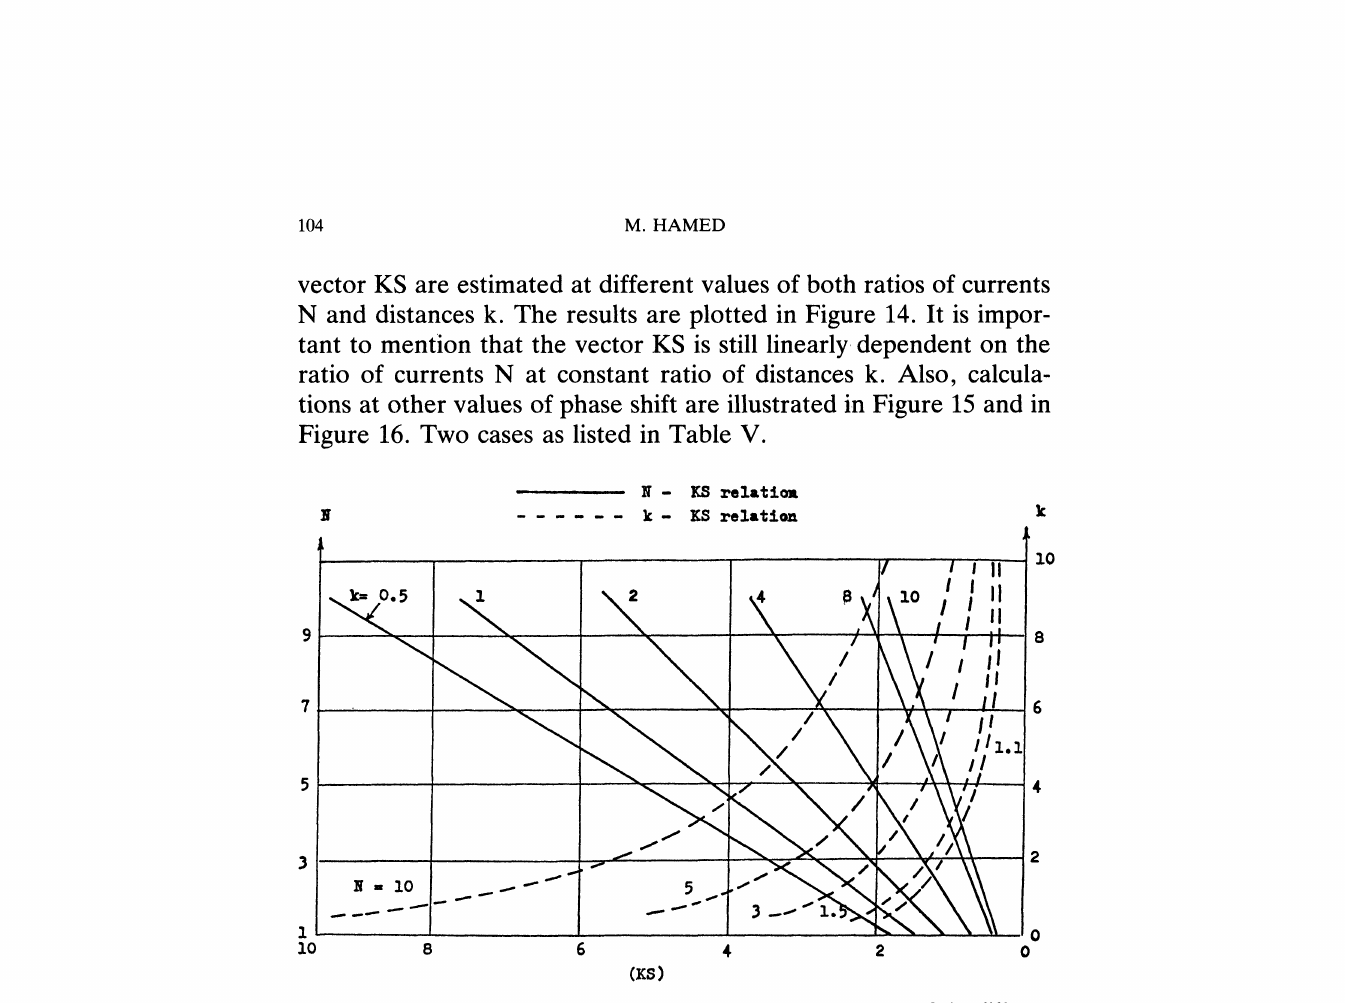
FIGURE 14 The calculated values of the coefficient KS at zero angle Q for different current ratios and distances.